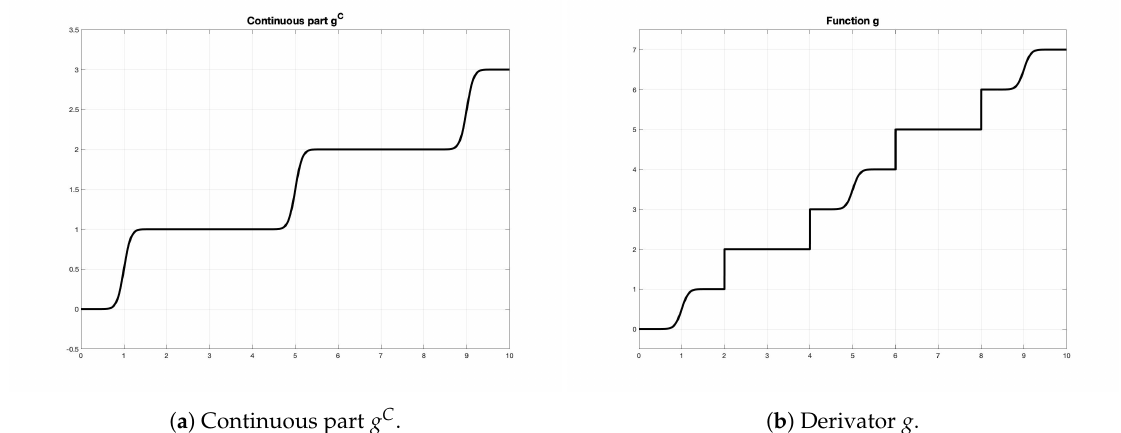
Figure 1. Example of continuous part g C and derivator g (vertical lines have to be understood as jumps and not as a multivalued function).